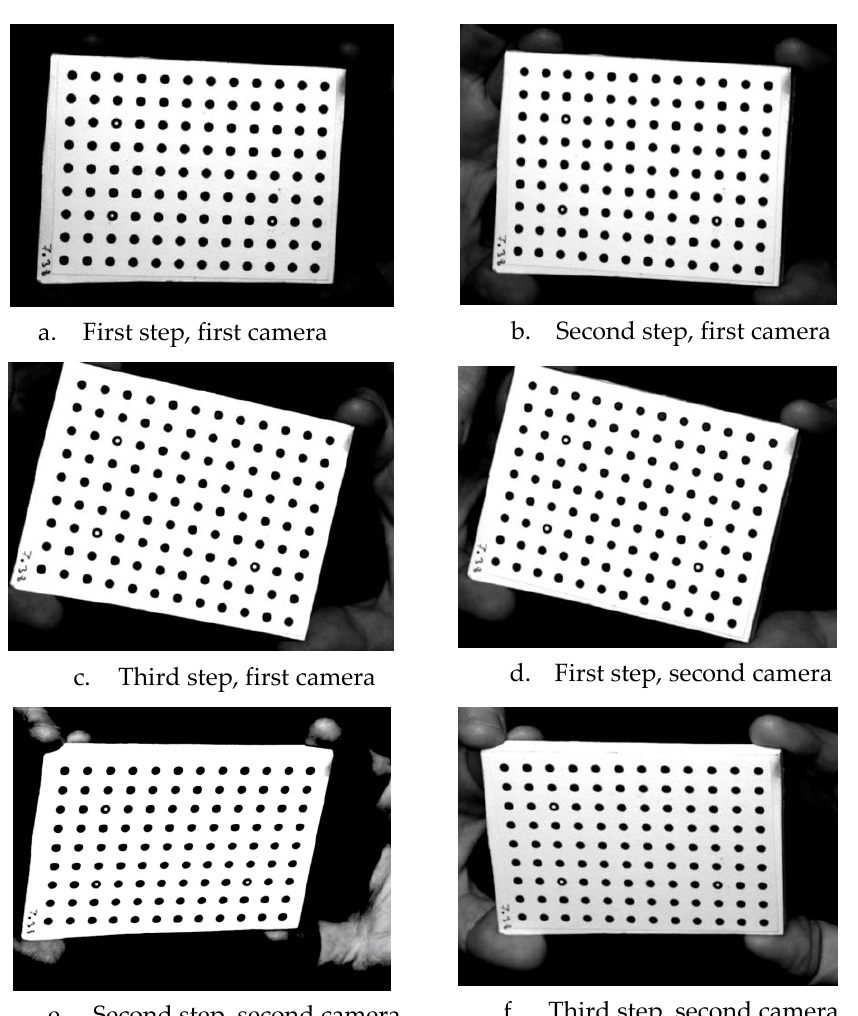
Figure 4. Different stages of the calibration process of each camera.